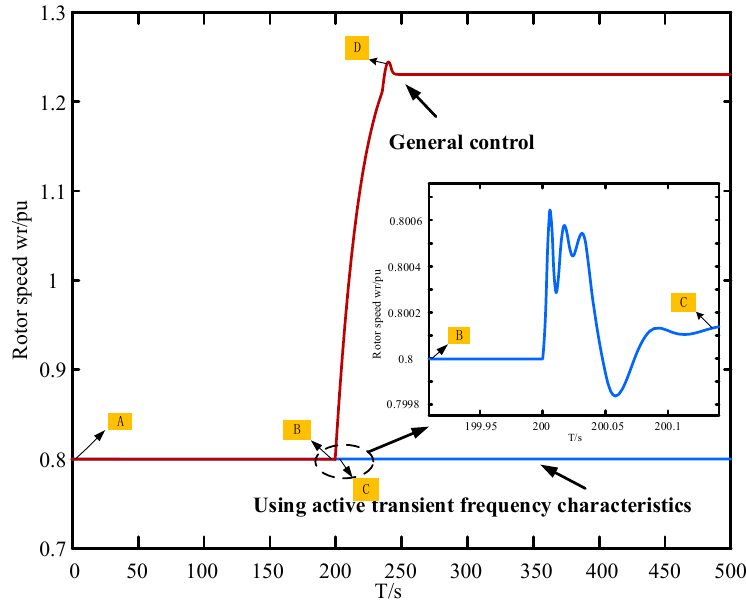
Figure 11. Rotor speed curve of doubly fed induction generator.